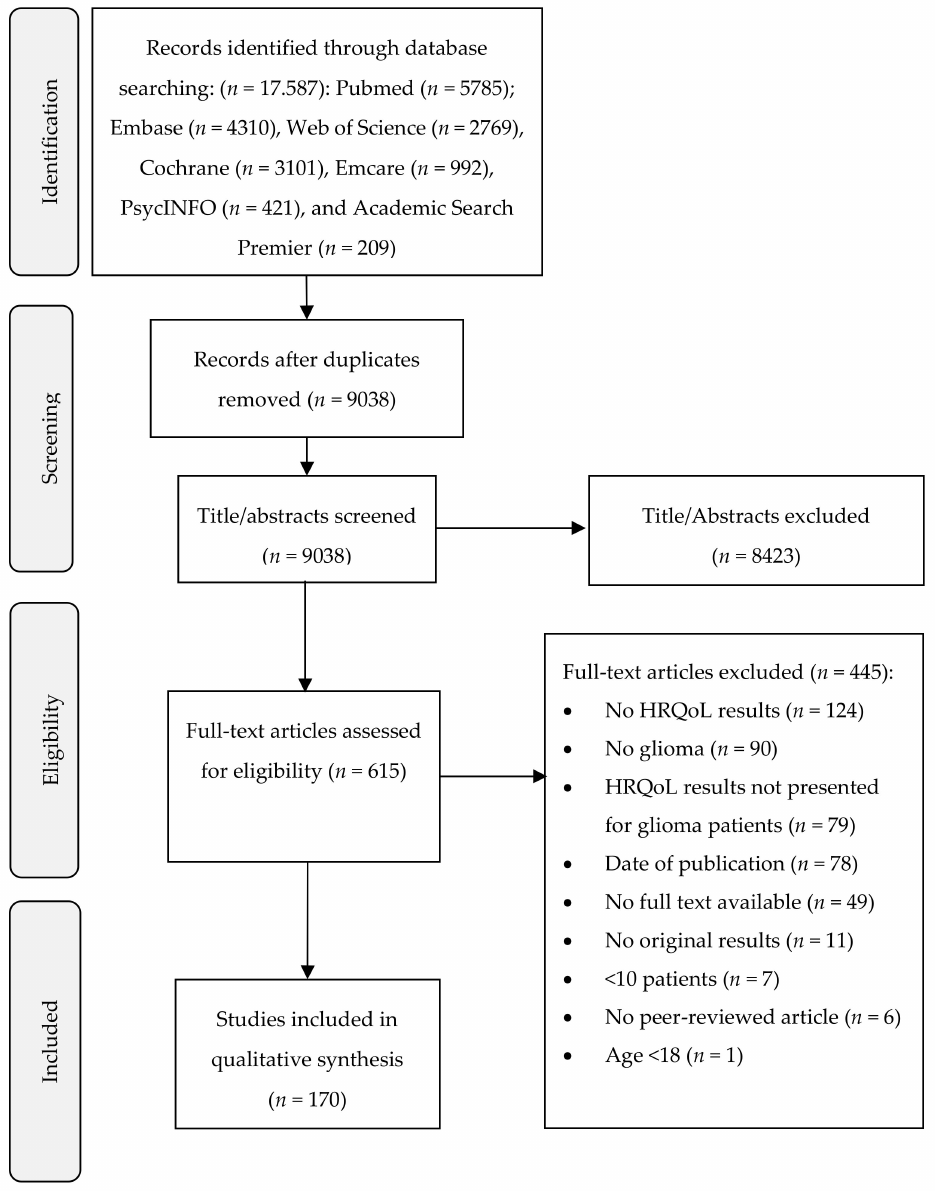
Figure 1. Flow diagram of study